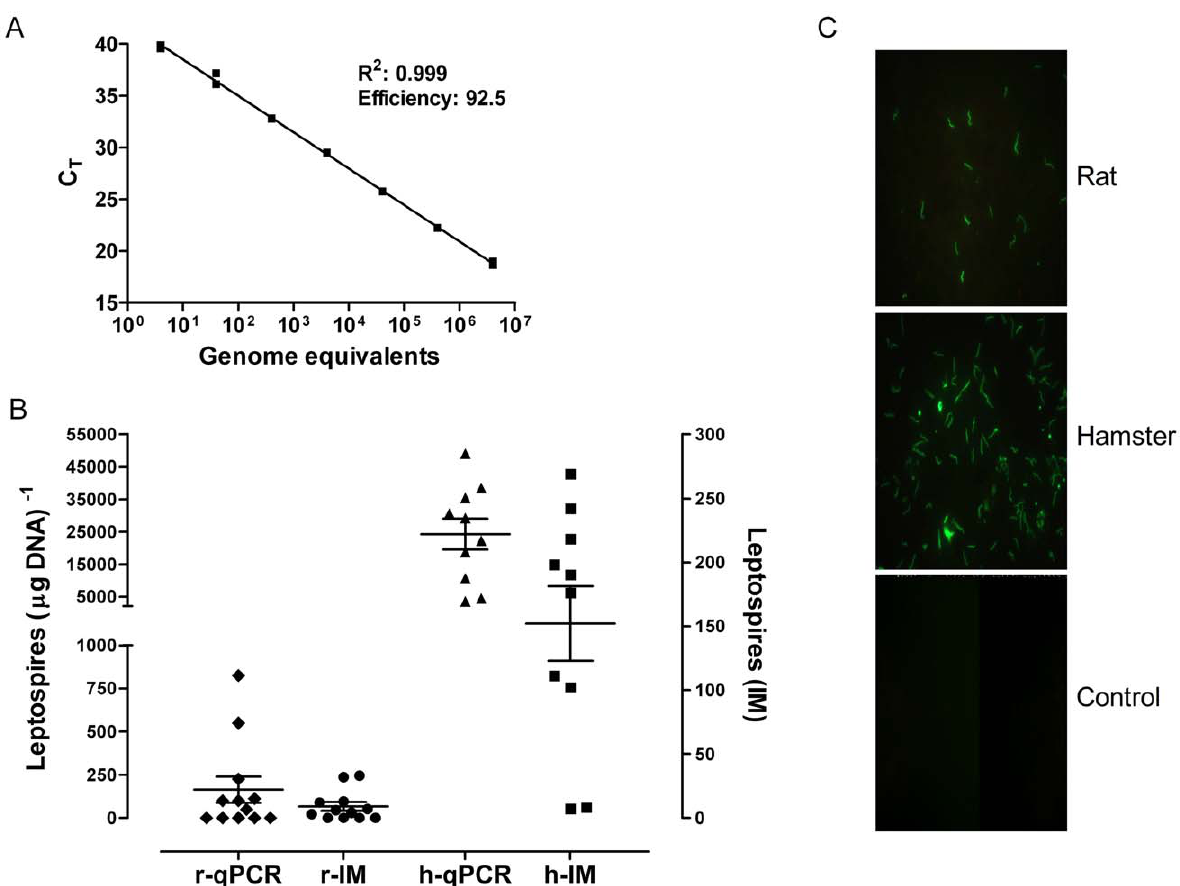
Figure 1. Quantification of leptospires by qPCR and the IM. A. Standard curve of the lipL32 real-time PCR assay using DNA extracted from ten- fold serial dilutions of an L. interrogans strain Cop culture. Each DNA sample was quantified in duplicate and repeated twice. B. Quantification of the leptospiral load in the rat and hamster models. Rats were infected with 10 8 leptospires and were euthanized on day 28 pi. Hamsters were inoculated with 500 leptospires (3 6 LD 50 ) and euthanized eight days pi. The leptospiral load in the kidneys was determined by qPCR (open symbols) and the IM (solid symbols). The leptospiral loads for the qPCR (leptospires per m g kidney DNA) and the IM (leptospires per 10 fields-of-view, 6 1000 magnification) for the rat (r) and hamster (h) are presented as a scatter dot plot of the individual values for each animal, the horizontal line represents the mean value and the error bars the SEM. C. Representative examples of the imprint slides using kidney samples from an infected rat, a hamster and a non- infected control animal (magnification 1000 6 ).